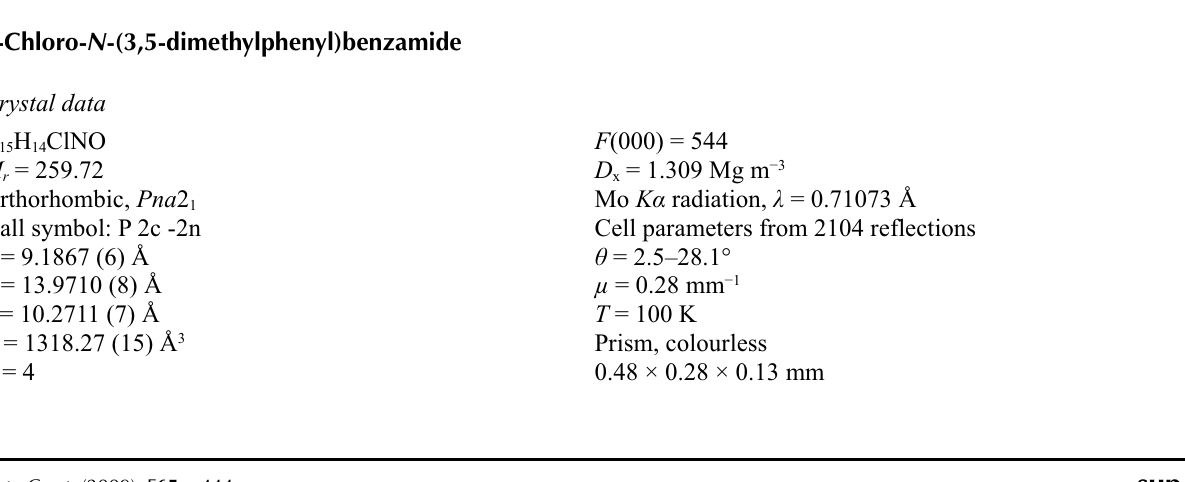
Molecular packing of the title compound with hydrogen bonding shown as dashed lines. 2-Chloro- N